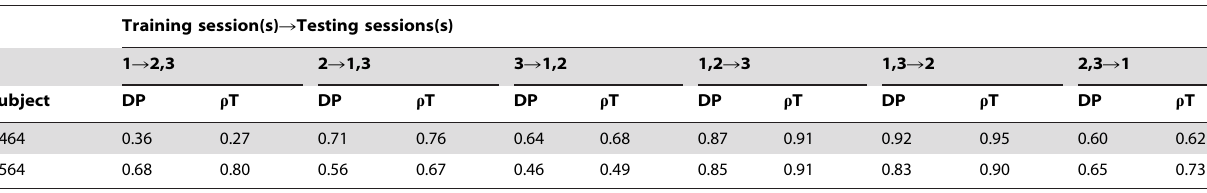
Training session(s) R Testing